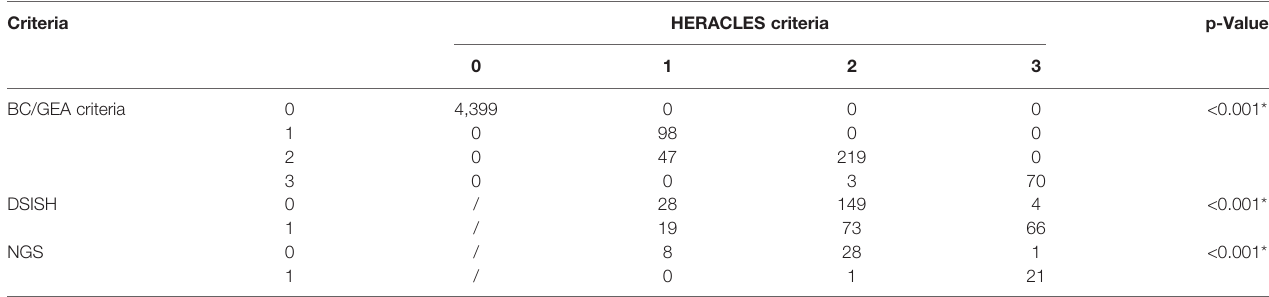
TABLE 1 | HER2 expression in different criteria and determination methods.